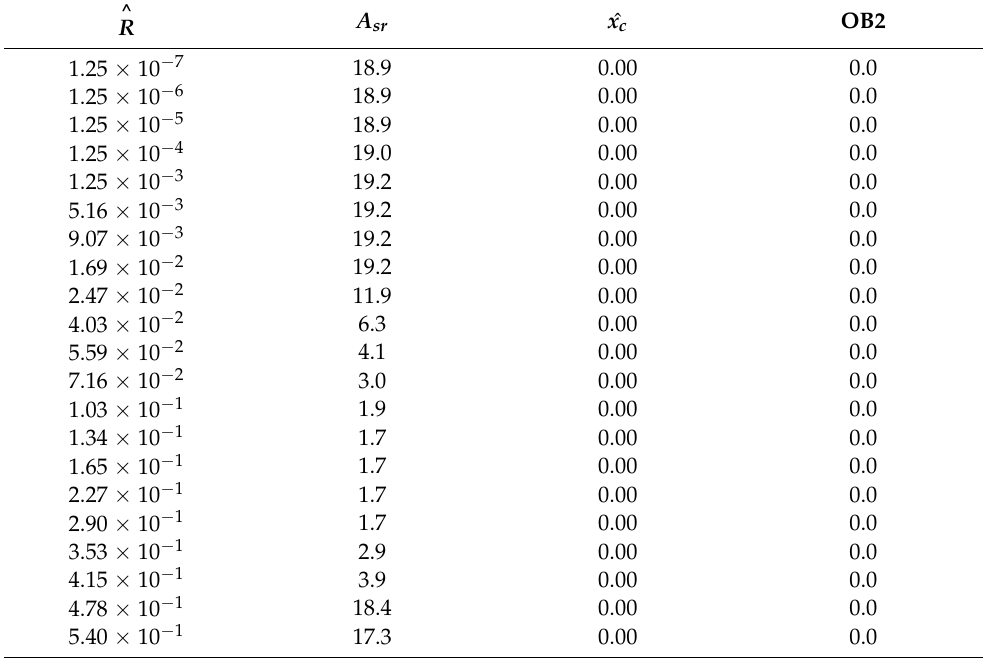
Table 4. Optimized dimensionless parameters for an RPSPV system using an objective function of Equation (35) at the surge tank